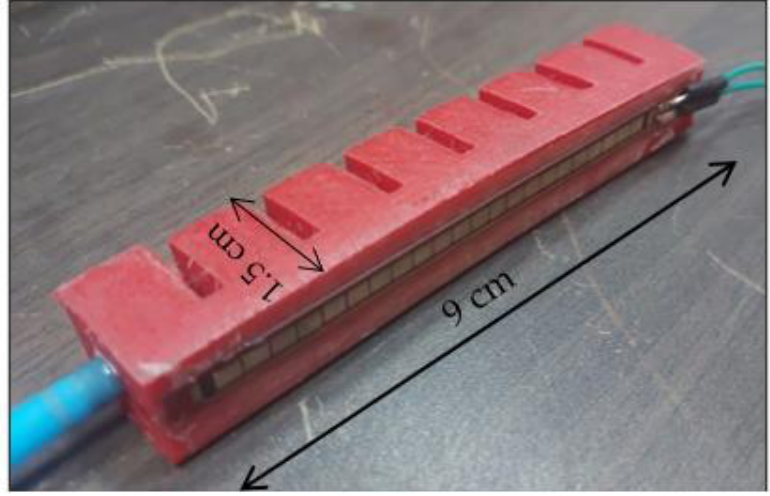
Figure 4. Flex sensor fixed on the soft actuator.